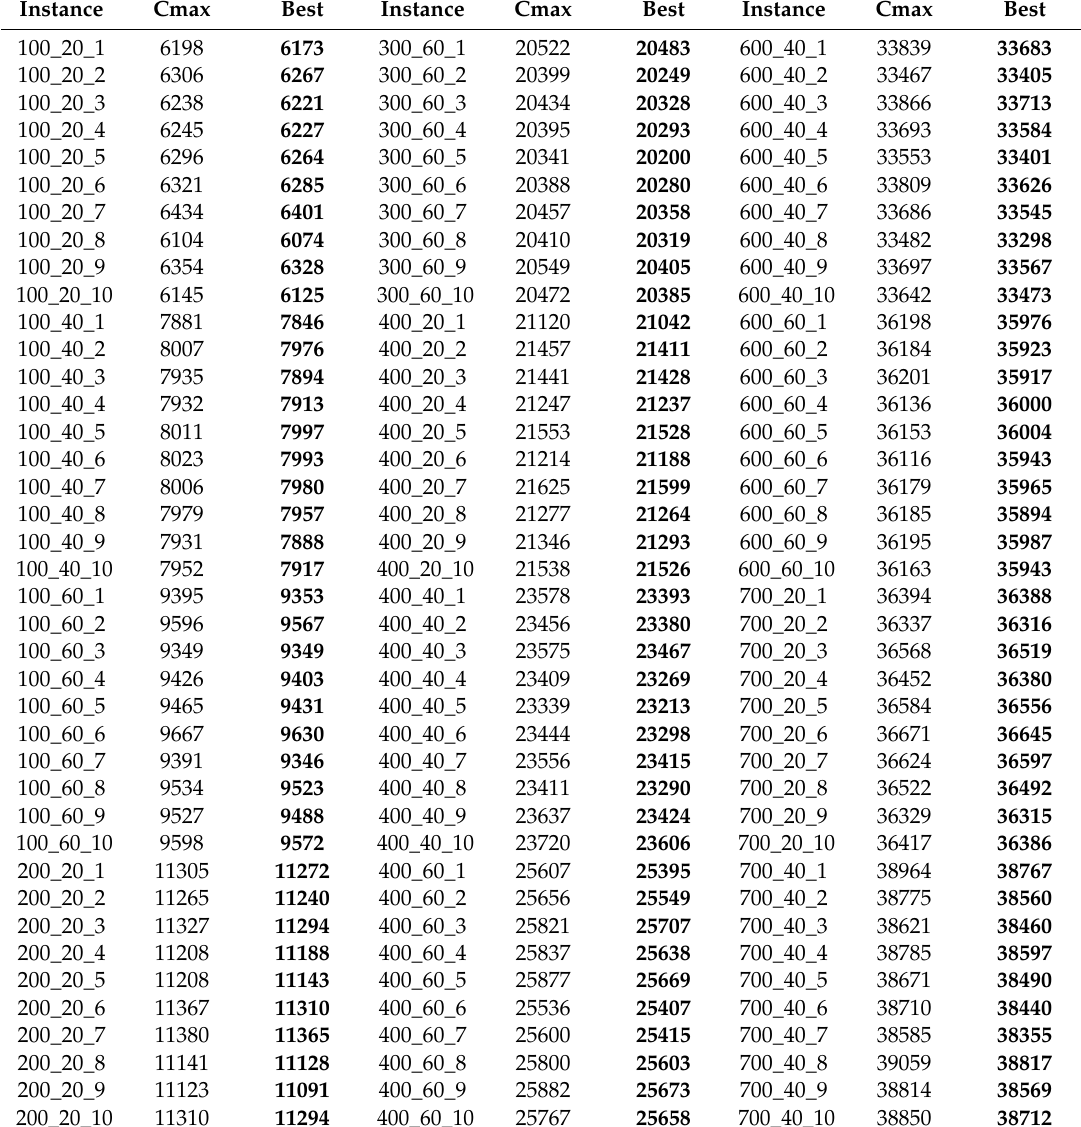
Table A5. New best solutions of our algorithms for Large VRF Instances (The bolds shows the new best known